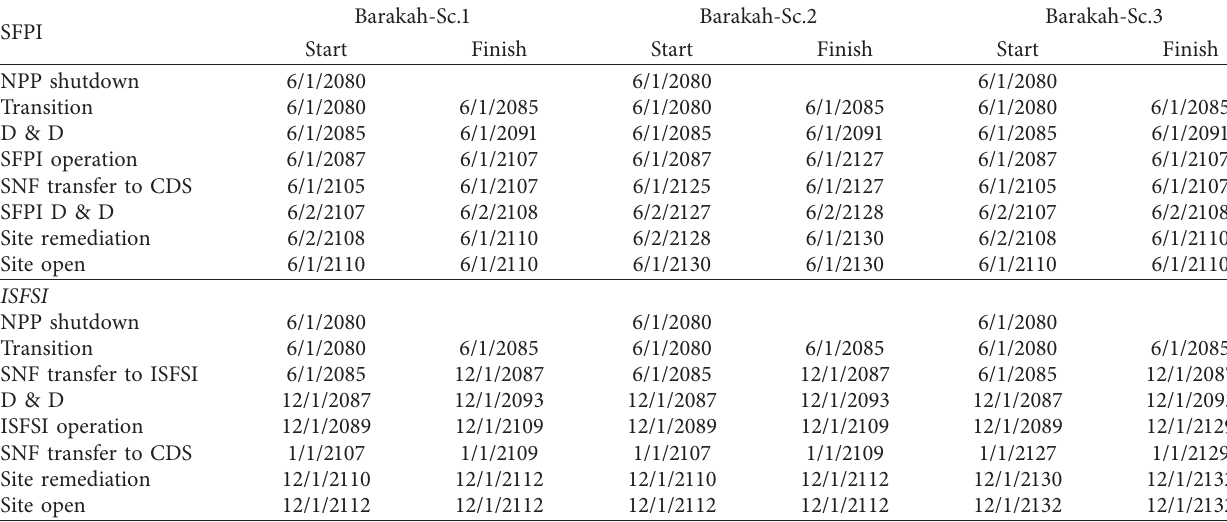
Table 6: Spent fuel transportation schedule showing effect of SFPI and ISFSI facility shifting times for all scenarios.